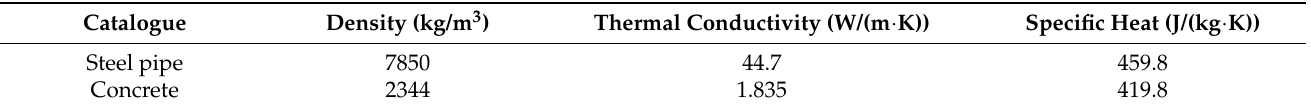
Table 7. Thermal physical